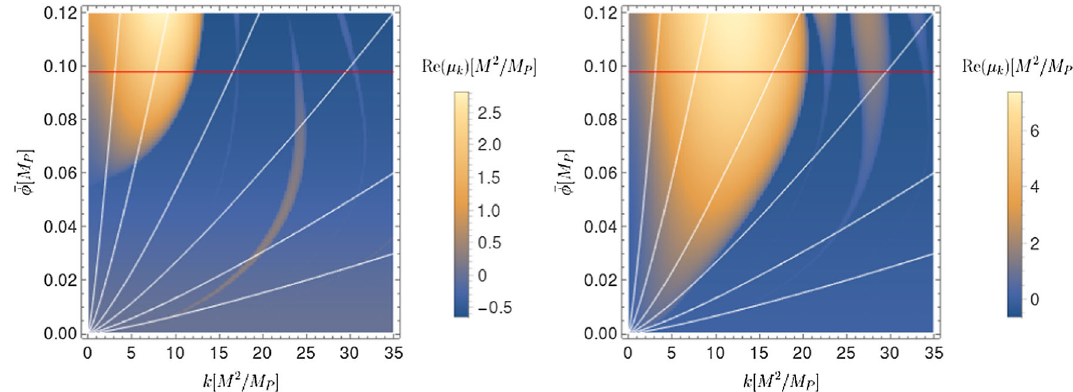
Fig. 4 Floquet exponents for the inflaton (left panel) and the spectator (right panel) perturbations with n = 3 / 2 and α = 10 − 3